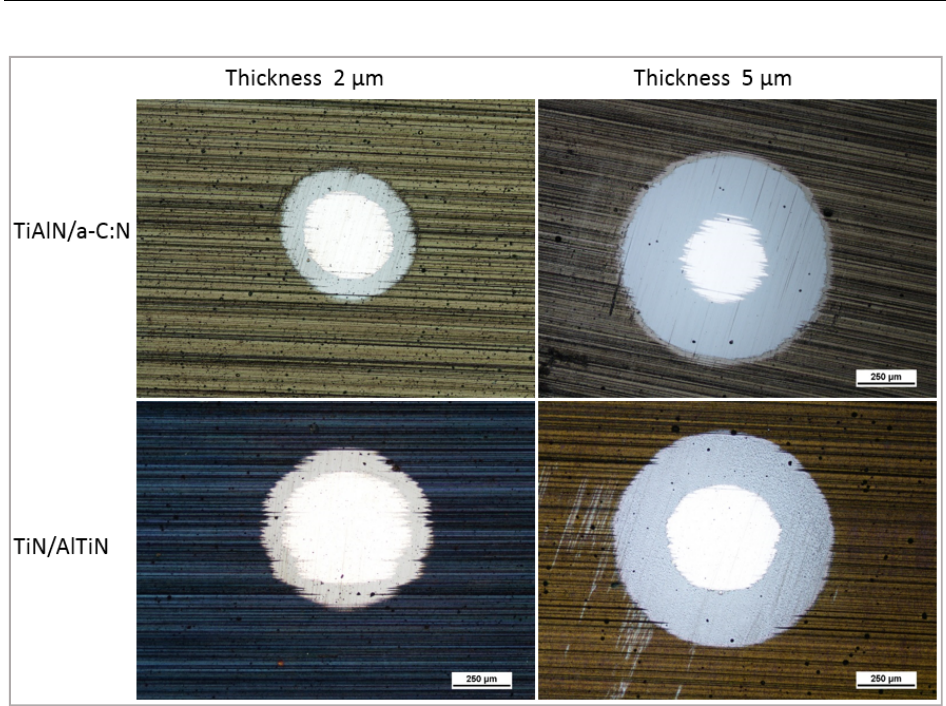
Figure 7. OM image of ball crater through the TiN/AlTiN and TiAlN/a-C:N coatings with the thickness of 2 and 5 µm, respectively.